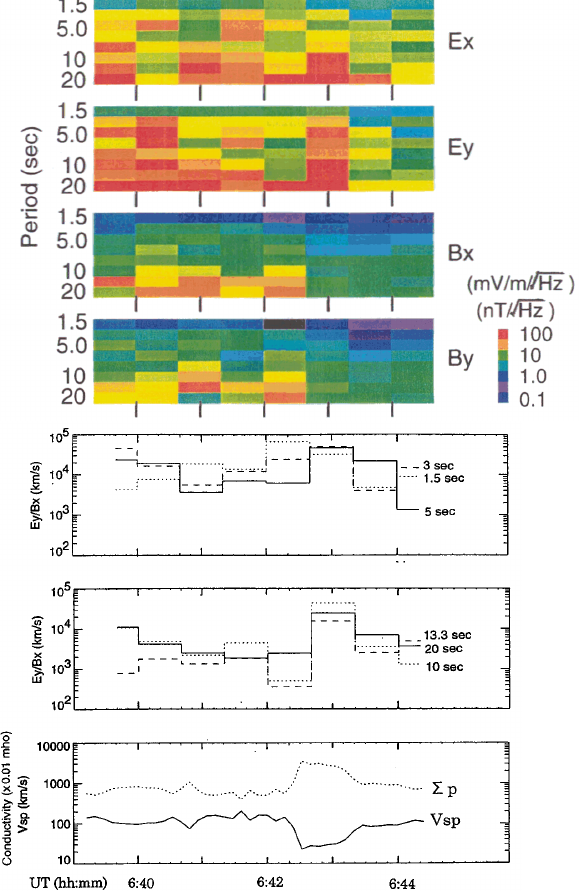
Fig. 2. From top to bottom: Spectral density of the two components of electric field and magnetic field measured by Akebono satellite. E/B ratios for fluctuations of 6 wave periods. Height-integrated Pederson conductivity and V sp = 1 /µ 0 6 p